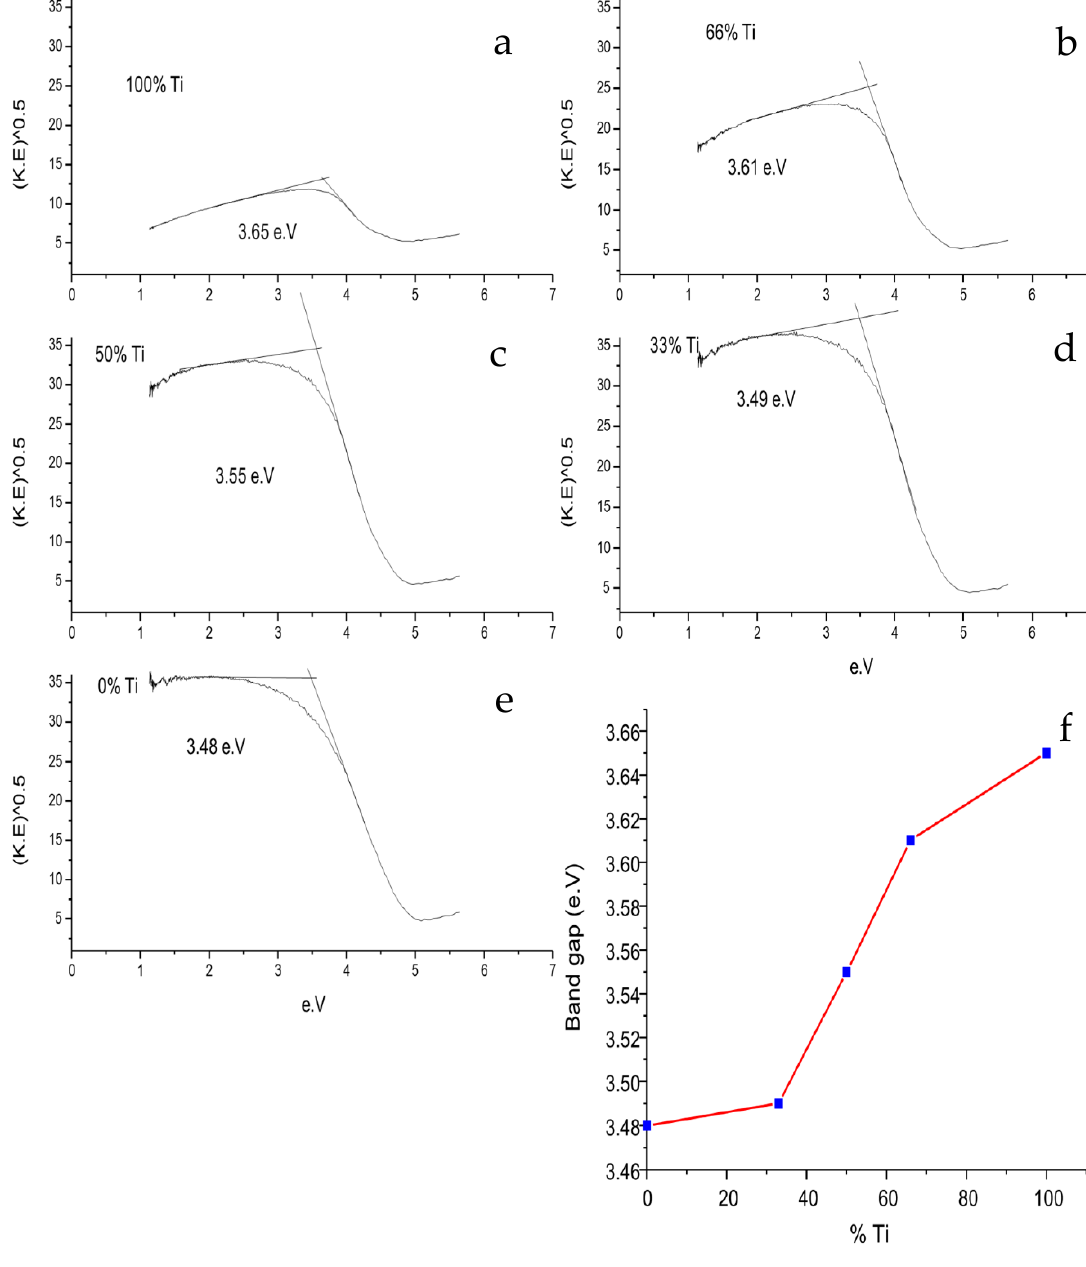
Figure 3. Kubelka–Munk method curves combined with a relation between percentage of Ti and band gap values: ( a ) 100% Ti; ( b ) 66%Ti; ( c ) 50% Ti; ( d ) 33%Ti; ( e ) 0 %Ti; ( f ) effect of %Ti on band gap.